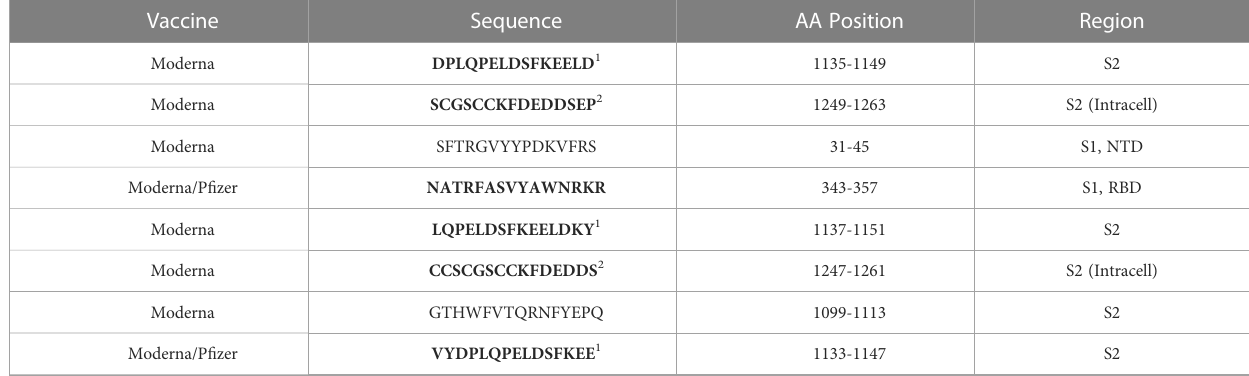
TABLE 2 Highly responsive peptides found in the vaccinated individual.